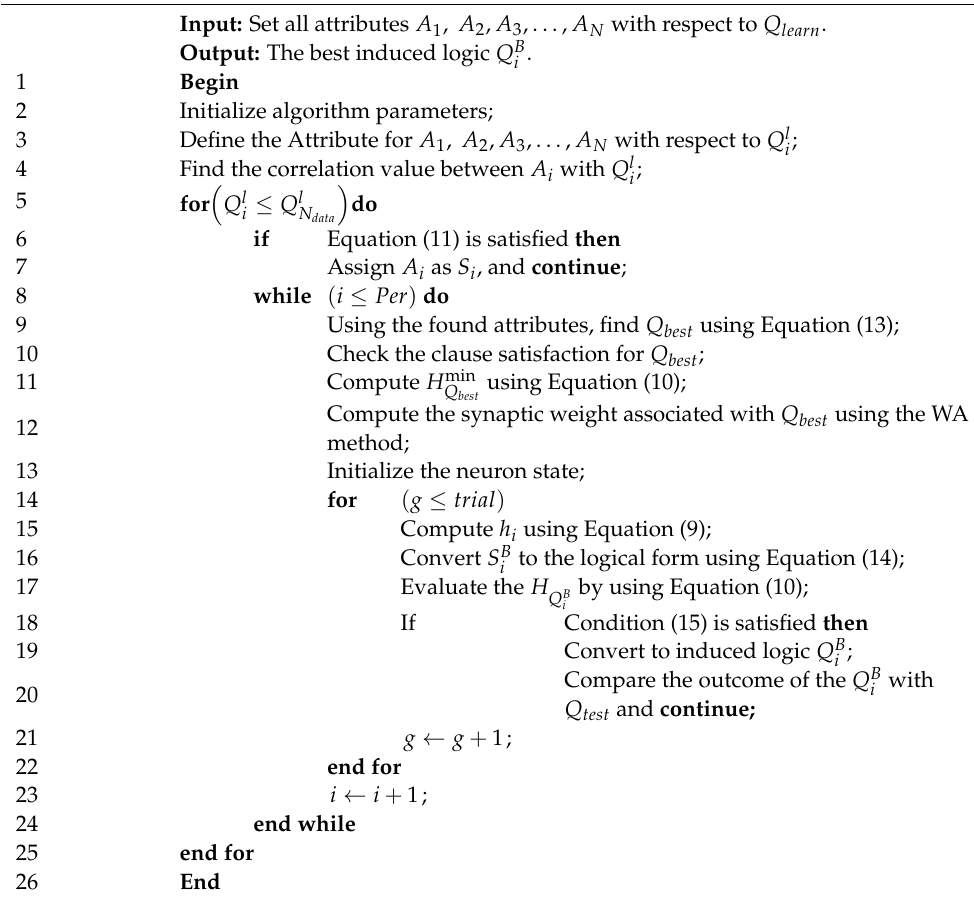
Algorithm 1. Pseudo code of the Proposed